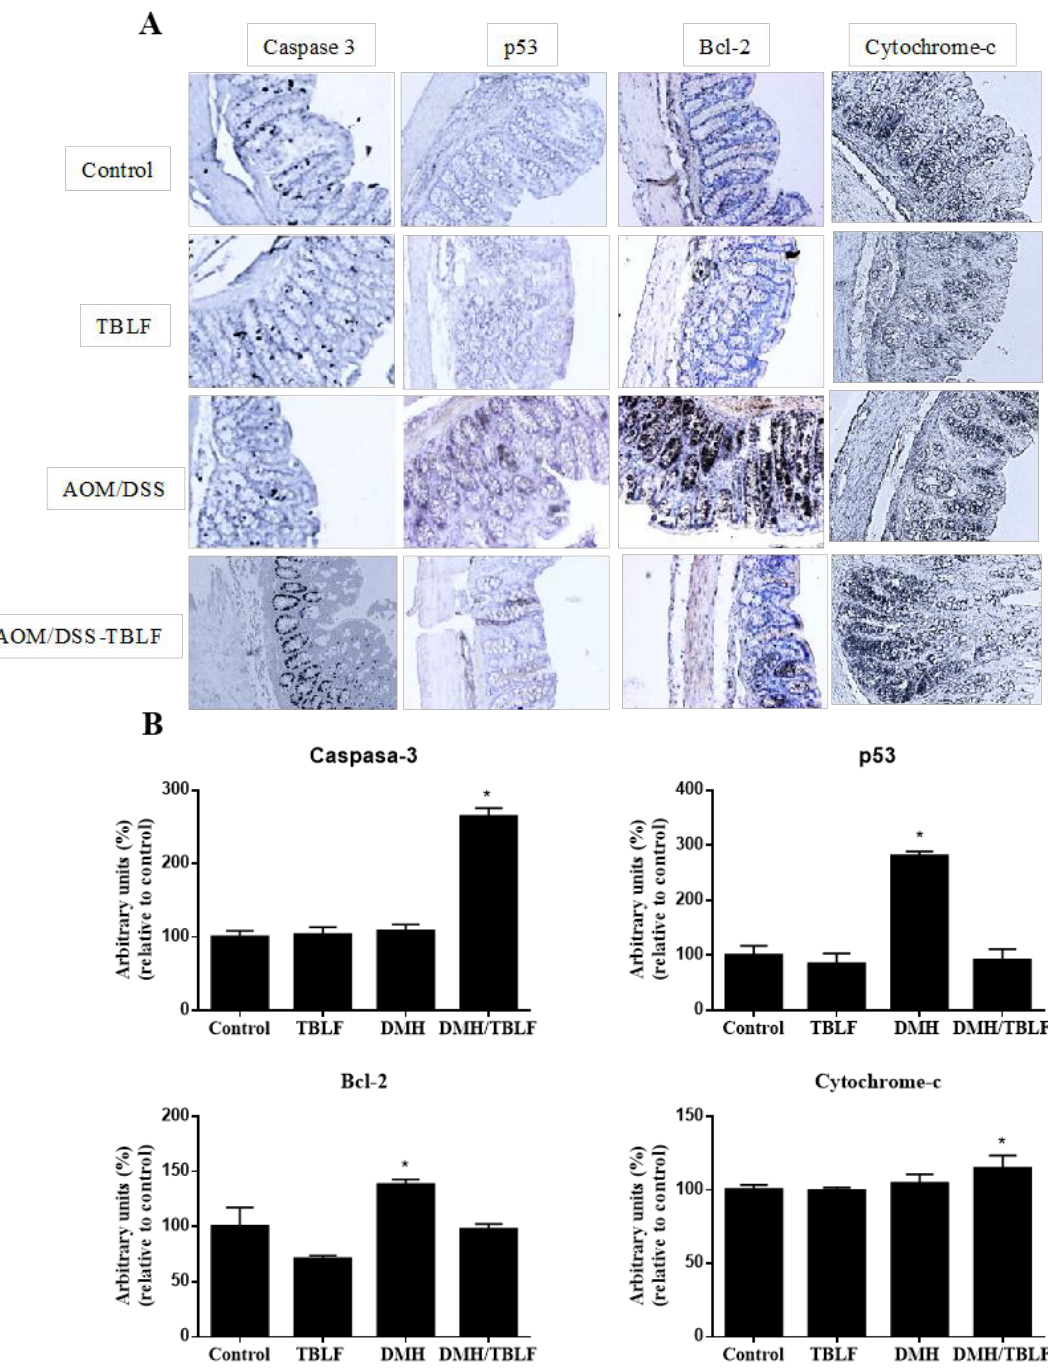
Figure 8. Immunohistochemical analyses of apoptosis markers in rats administered with AOM/DSS and treated with TBLF. Rats were intraperitoneally administered for two weeks with AOM and a further two weeks with DSS in their daily drinking water to develop ACF. Next, they were administered with TBLF (50 mg/kg) on alternate days for six weeks via intra-gastric cannula. ( A ) Representative micrographs of each group (10 × ); ( B ) Densitometry analyses of immuno-stained colon tissues. (*) Significant difference by one-way ANOVA (Dunnett p < 0.05).